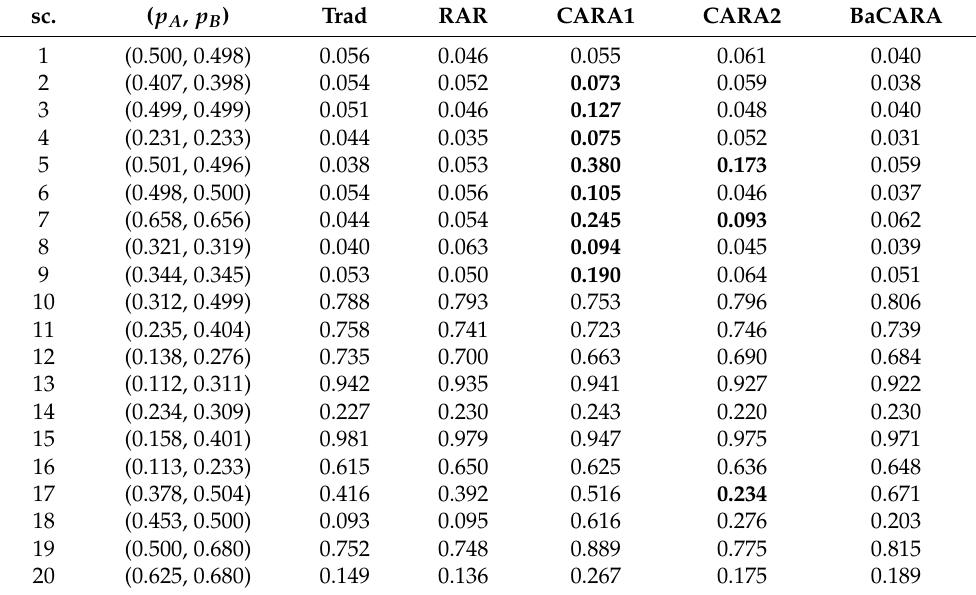
Table 2. Simulation results: estimated rejection probability of the designs when x 1 and x 2 are independently generated from a Bernoulli distribution with response probability 0.5. Note that “sc” denotes scenarios. The bold indicates the inflation of error rates.